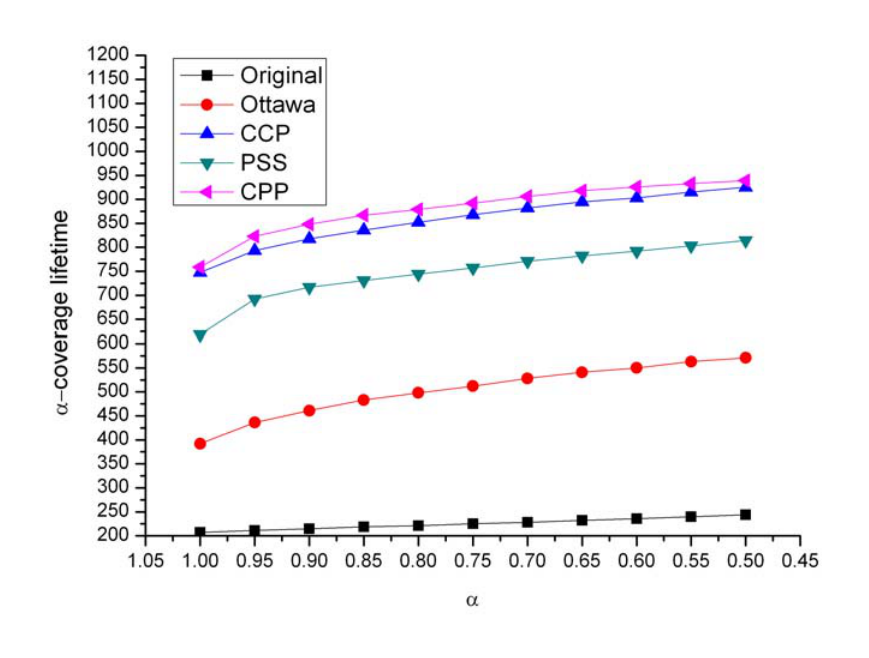
Figure 11. Network  -coverage